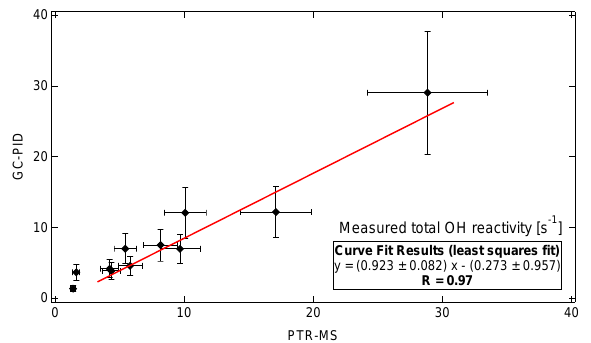
Fig. 7. Correlation plot and linear least squares fit for standard mea- surements of PTR-MS and GC-PID in parallel as detector for total OH reactivity. As standard gas propane and propene have been in- troduced into the system in a known amount and the total OH reac- tivity was detected with both